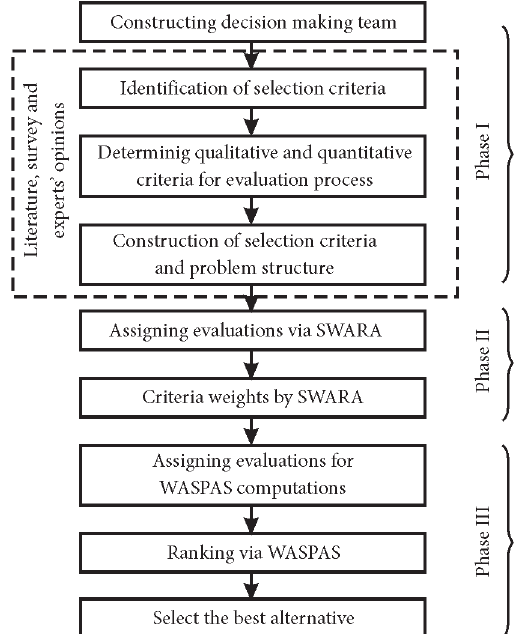
Fig. 1. Schematic representation of the process proposed for real-time intelligent sensors for structural health monitoring of bridges selection